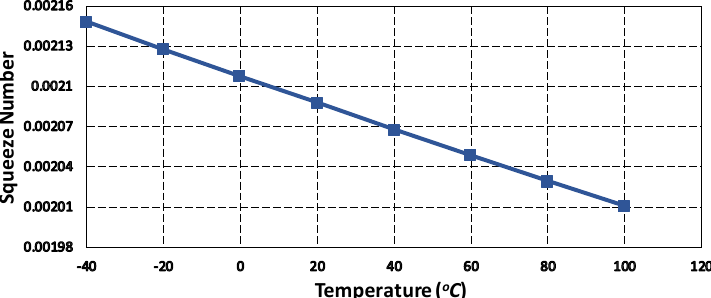
ff ect temperature variations on the squeeze number for the proposed MEMS Figure 6. Effect temperature variations on the squeeze number for the proposed MEMS gyroscope. Figure 6. E